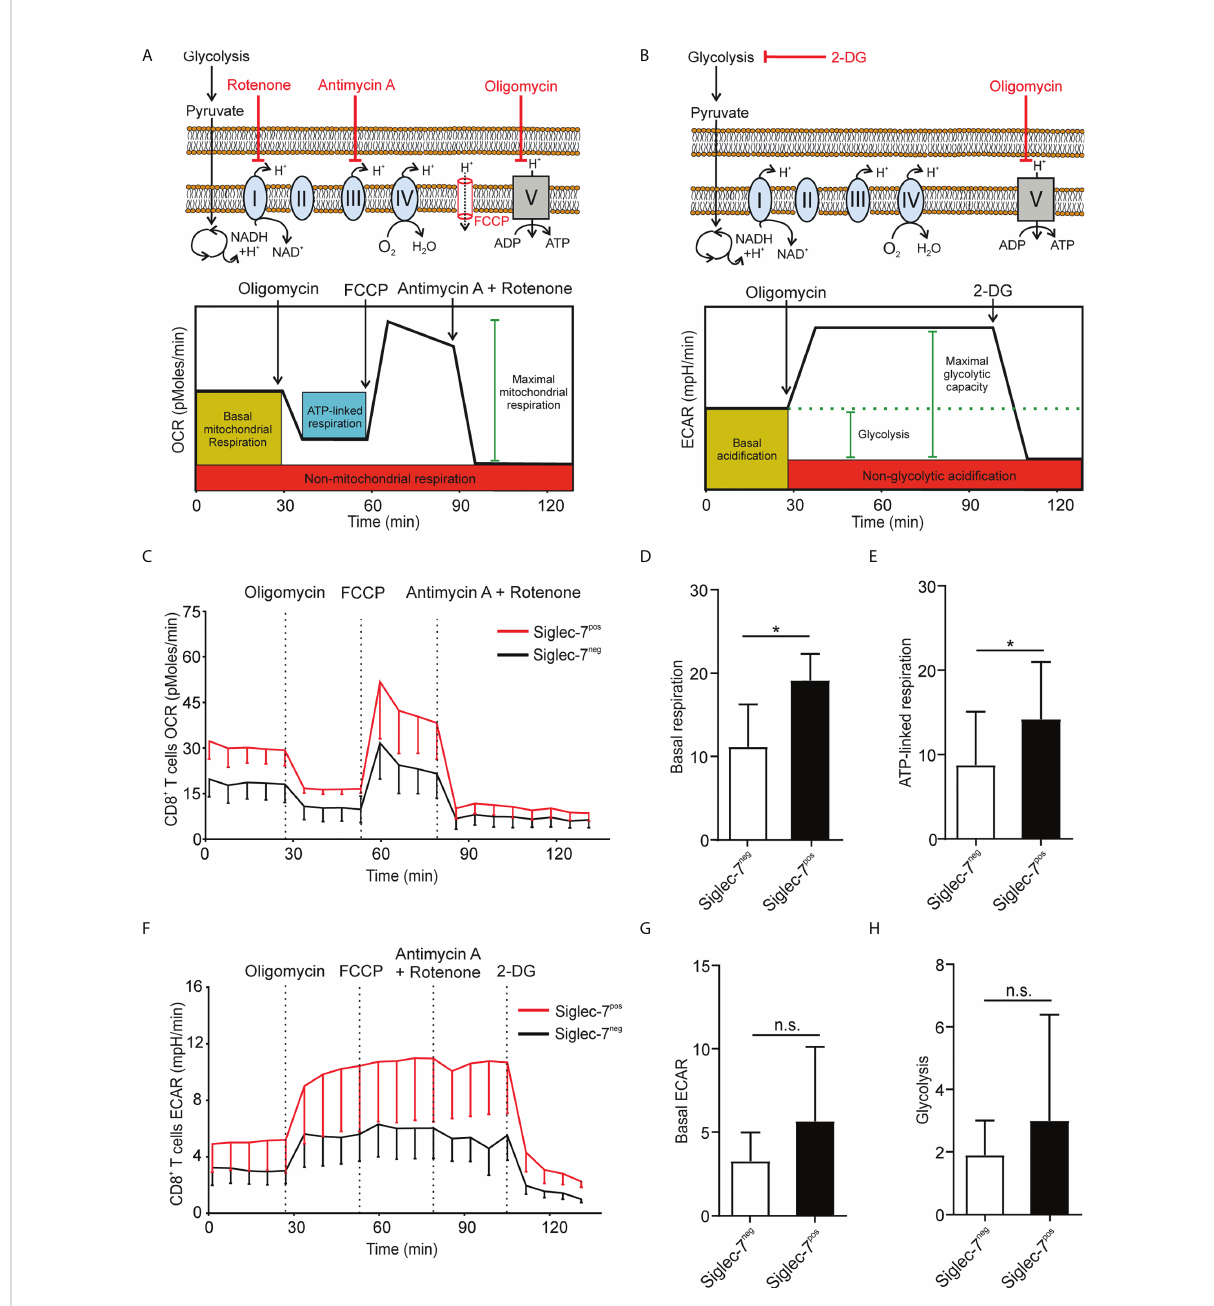
FIGURE 2 Siglec-7+ CD8+ T cells display a higher oxidative phosphorylation capacity at steady state. (A, B) Schematic illustrations of expected effects of oligomycin (ATPase inhibitor), FCCP (mobile ion carrier), 2-deoxy-D-glucose (2-DG, glucoprivic agent), and antimycin A (cytochrome C reductase blocker) and rotenone (complex I blocker) on oxygen consumption rate (OCR) (A) and extracellular acidi fi cation rate (ECAR) (B) . (C – H) Comparative OCR or ECAR analysis of isolated Siglec-7 + and Siglec-7 - CD8 + T cells from healthy donors by Seahorse (three independent experiments with 2-4 donors each, 11 donors in total). OCR pro fi le (C) , basal respiration (steady state mitochondrial respiration) (D) , and ATP- linked respiration ( D OCR after oligomycin injection) (E) . ECAR pro fi le (F) , basal acidi fi cation (ECAR at steady state) (G) , and glycolysis ( D ECAR at steady state minus non-glycolytic acidi fi cation in response to 2-DG injection) (H) . Statistical analysis was performed by paired t test (D, E, G, H) . *P < 0.05; n.s., not signi fi cant. Error bars, SD (D, E, G, H) or SEM (C, F)